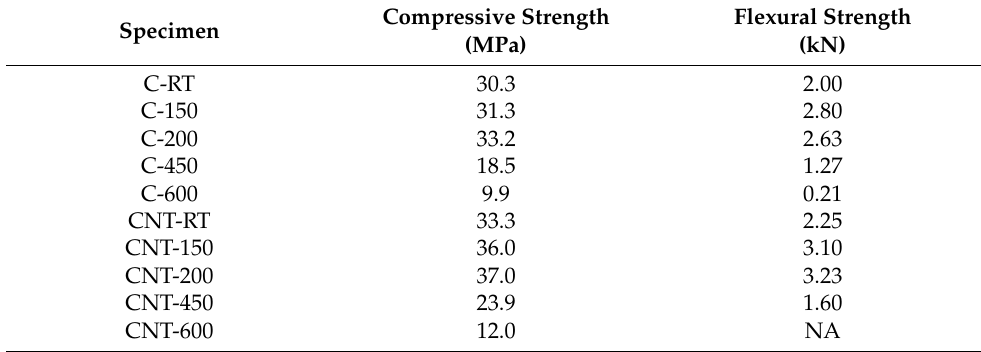
Table 4. Mechanical strengths